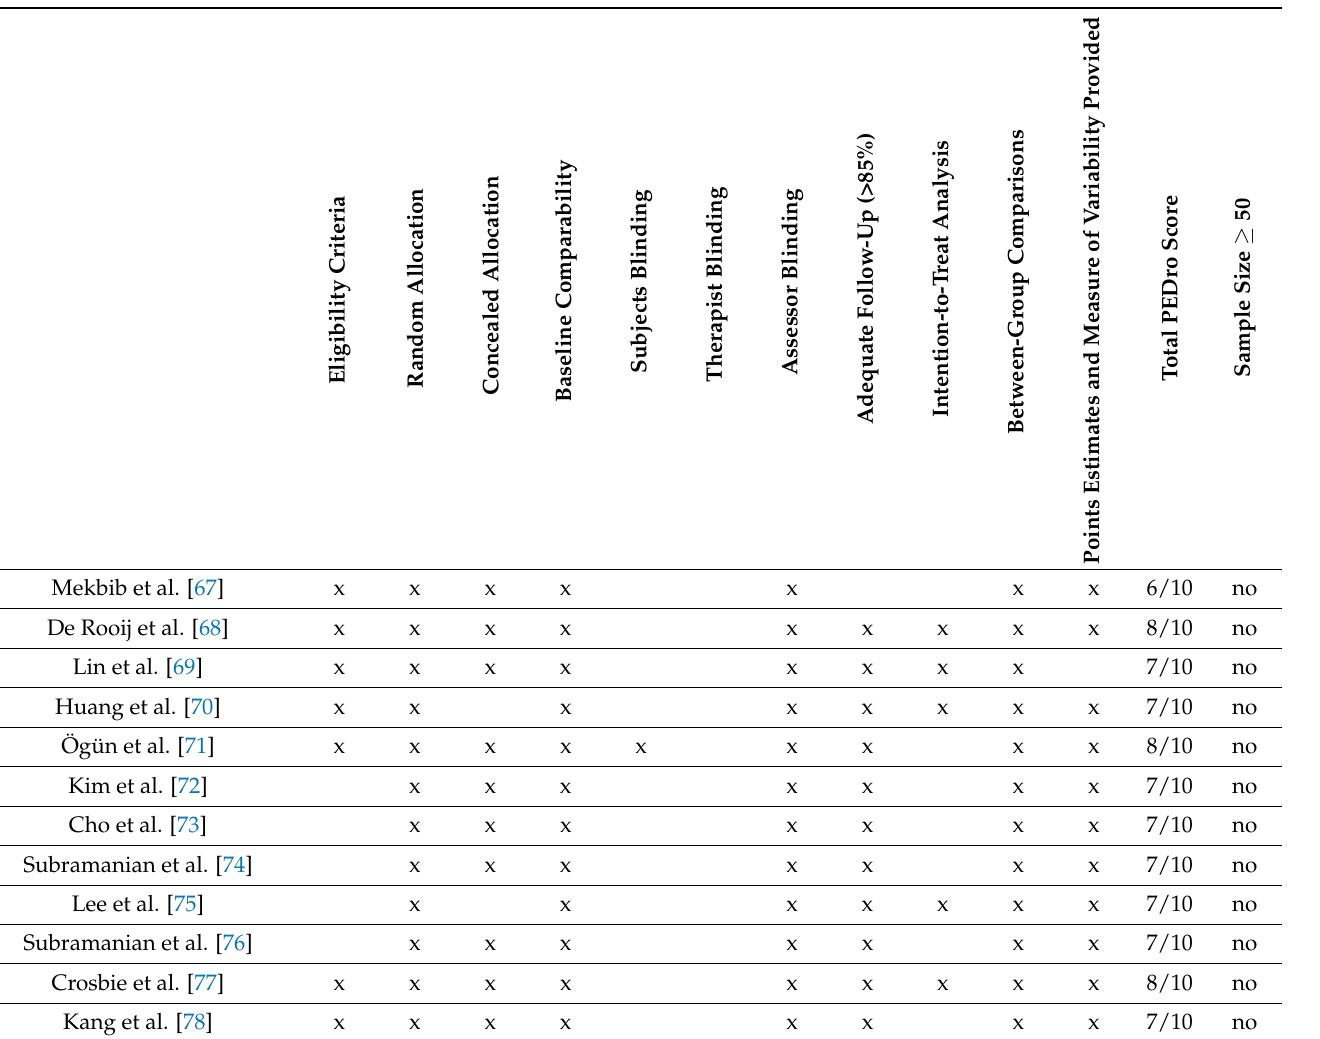
Table 1. Studies quality assessment (PEDro